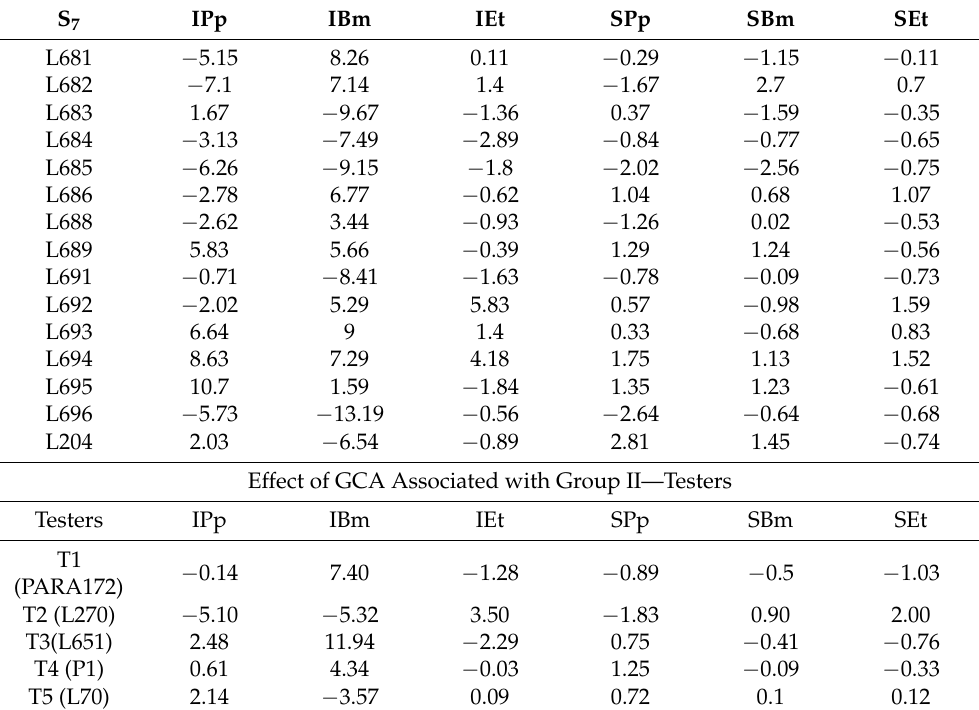
Table 3. Estimates of the effects of general combining ability ( ĝ i) associated with S 7 progenies (Group I) and testers (Group II) for agronomic traits and associated with P. polysora , B. maydis, and E. turcicum .